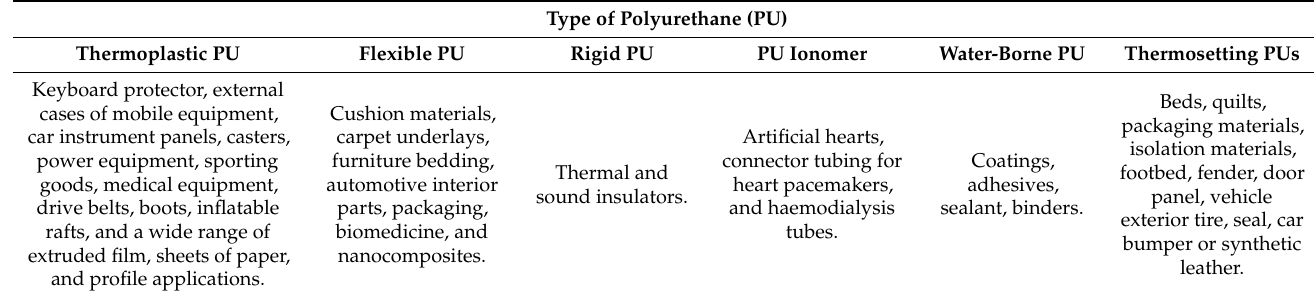
Table 1. Essential types of PUs and their typical applications